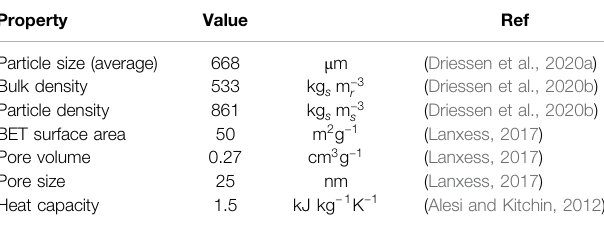
TABLE 1 | Physical properties of Lewatit® VP OC